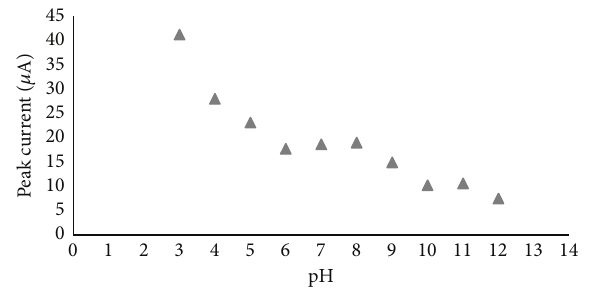
Figure 8: Effect of solution pH on the electrocatalytic activity of a SWCNT/Ni-modified GCE. Scan rate: 100 mVs −1 . pH: 3–12.